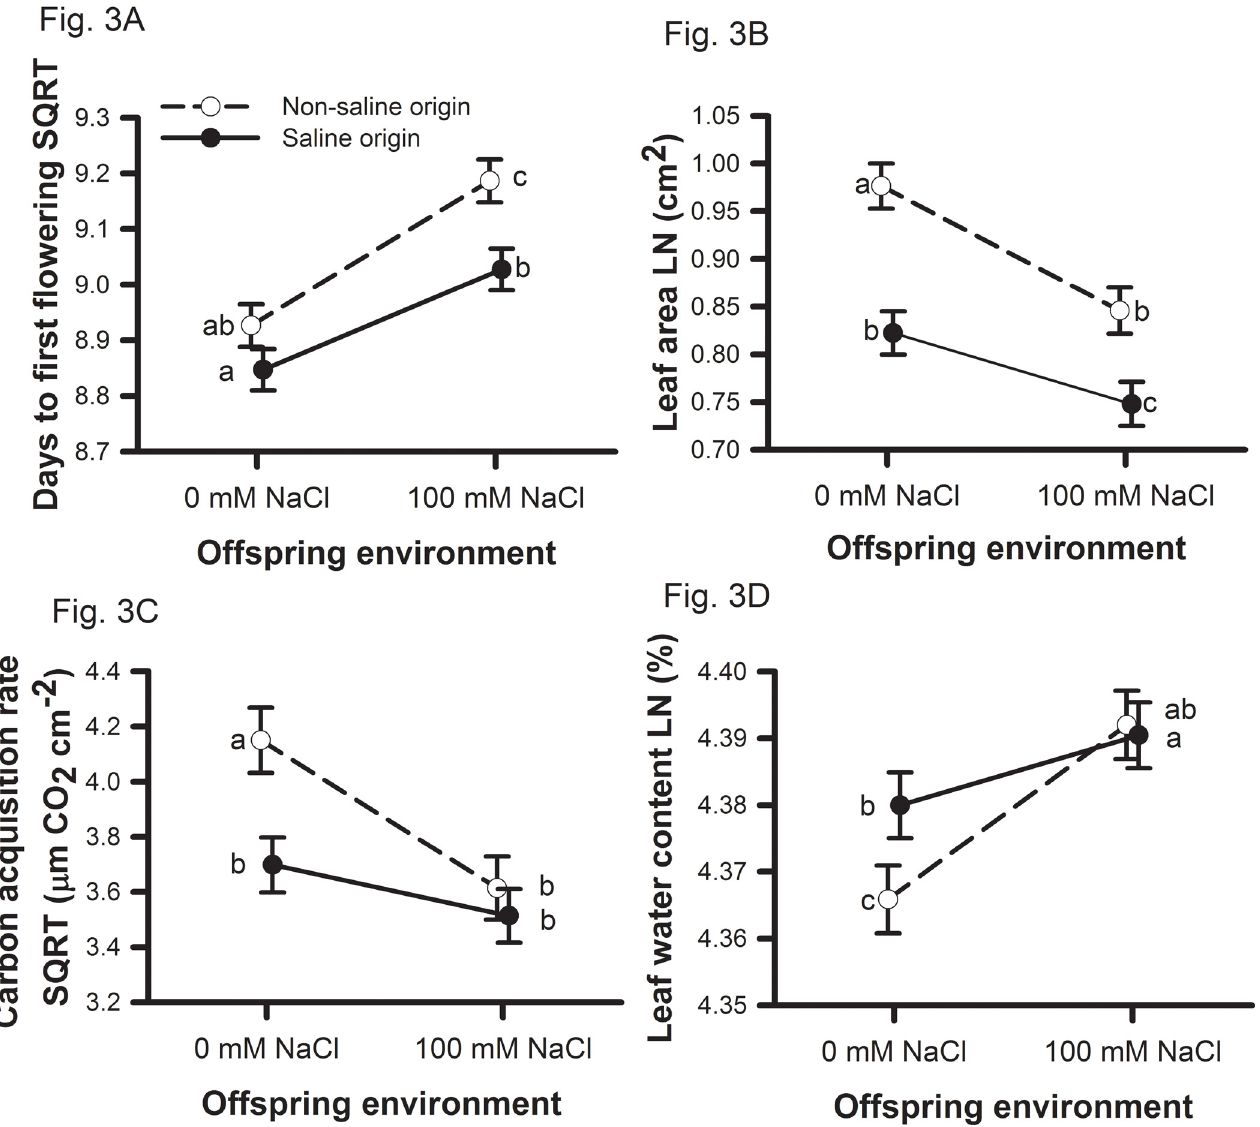
Fig 3. Origin of population offspring environmental effects on offspring traits. Origin of population means and one standard error for significant effects found for (A) days to first flowering, (B) leaf area, (C) carbon acquisition rate, and (D) leaf water content. Non-saline origins are shown with open circles and saline origins are shown with closed circles. Symbols with different letters indicate which means are significantly different at P < 0.05.